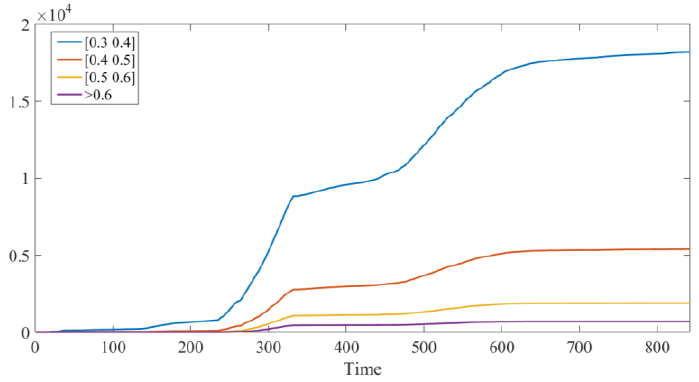
Figure 21. Debris counts in different amplitude intervals.